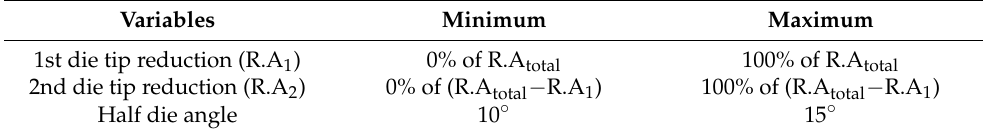
Table 6. Range of learning for the MRD.